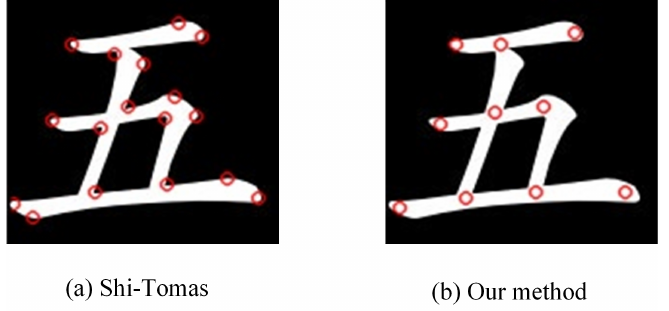
Figure 5. With the same nonmaximum suppression, ( a ) is the feature point detected result using the Shi-Tomas Corners, and ( b ) is the result using our method. This proves that our method can perform feature point detection accurately.